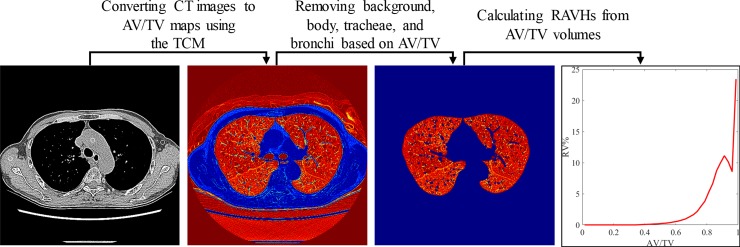
Processing procedures of patient CT images.The CT images were converted to AV/TV maps using the TCM with the measured CT numbers of muscle and air. The background, body, tracheae, and bronchi were segmented and removed from the map based on the AV/TV value. Relative air volume histograms were calculated from the AV/TV volumes.